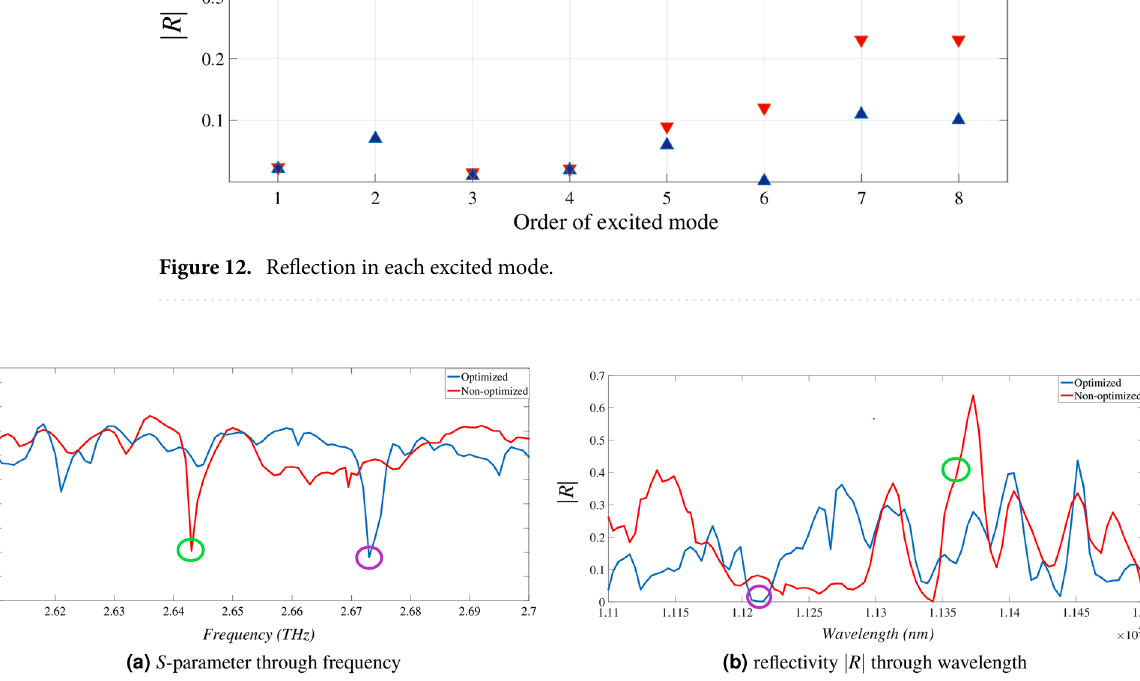
Figure 13. Results for 2nd excited mode where optimization details are